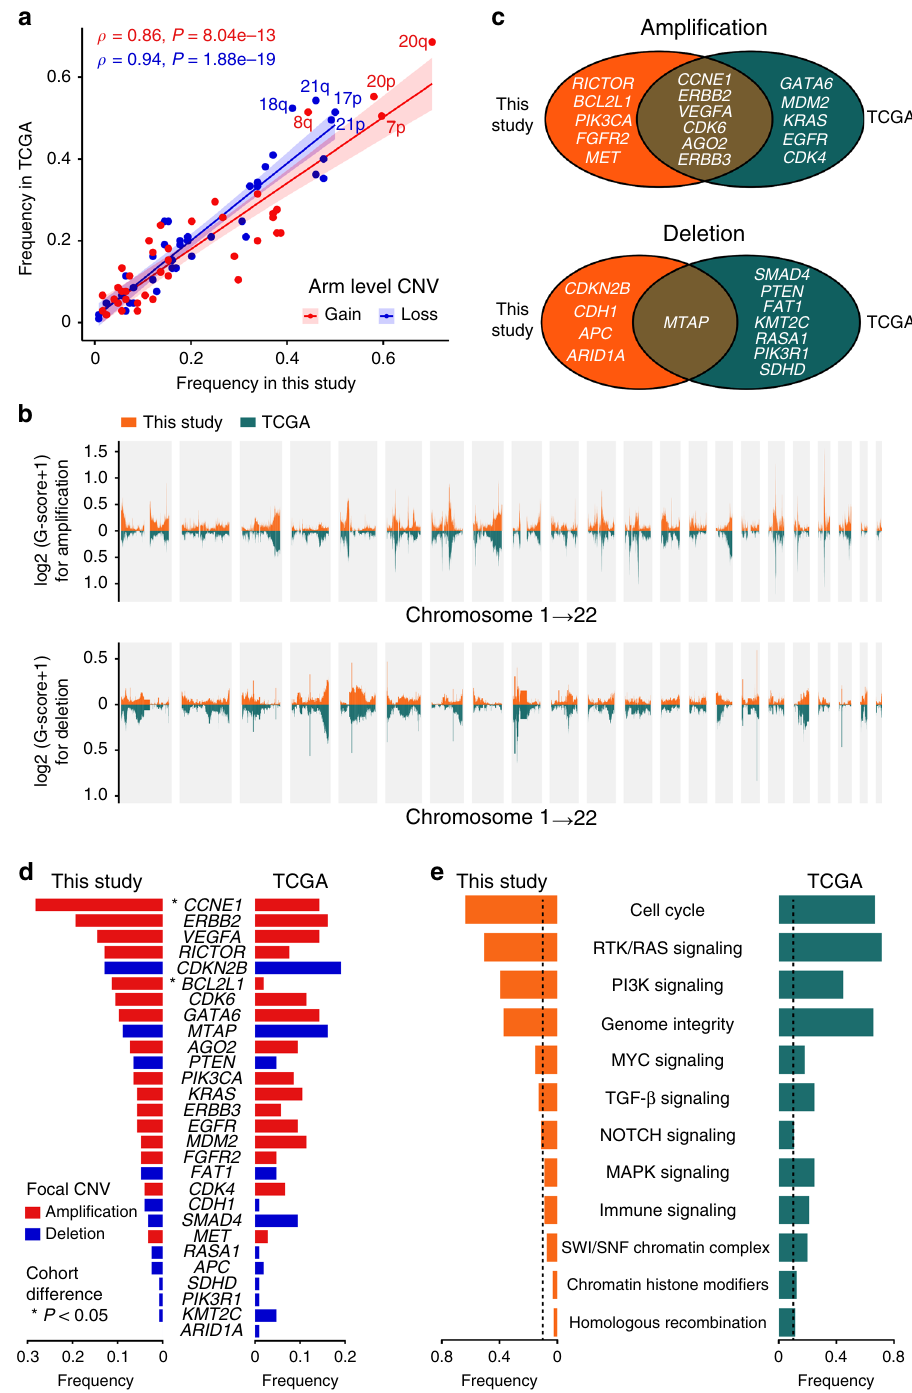
Fig. 3 Comparison on genomic alterations between our patients and TCGA patients. a Correlations of arm level CNV frequencies between our tumor samples and TCGA samples. Red and blue represent arm level gain and loss, respectively. b Bar plots comparing log2-tranformed GISTIC G-scores, a measure for both frequency and amplitude, of focal copy-number gain (upper panel) and loss (lower panel) regions in our tumor samples and TCGA samples. c Shared and unique putative CNV driver genes targeted by recurrent focal copy-number gains (upper panel) and losses (lower panel) in our samples and TCGA samples. d Bar plots comparing ampli fi cation (red) and deletion (blue) frequencies of putative CNV driver genes ( c ) across two cohorts. Genes with signi fi cantly different alteration frequencies in two cohorts ( P < 0.05) were asterisked. e Bar plots comparing the frequencies of featured pathway perturbations across two cohorts. Dashed lines indicate 10% alteration different rates (Fig. 3e). In addition, MAPK signaling (e.g., KRAS , both cohorts, we found recurrent perturbations (>10% samples) to the cell-cycle, receptor tyrosine kinases (RTK)/RAS, PI3K, MYC, TGF- β , and NOTCH signaling pathways, and to genome integrity related genes (e.g., TP53 , MDM2, and ERCC2 ), with